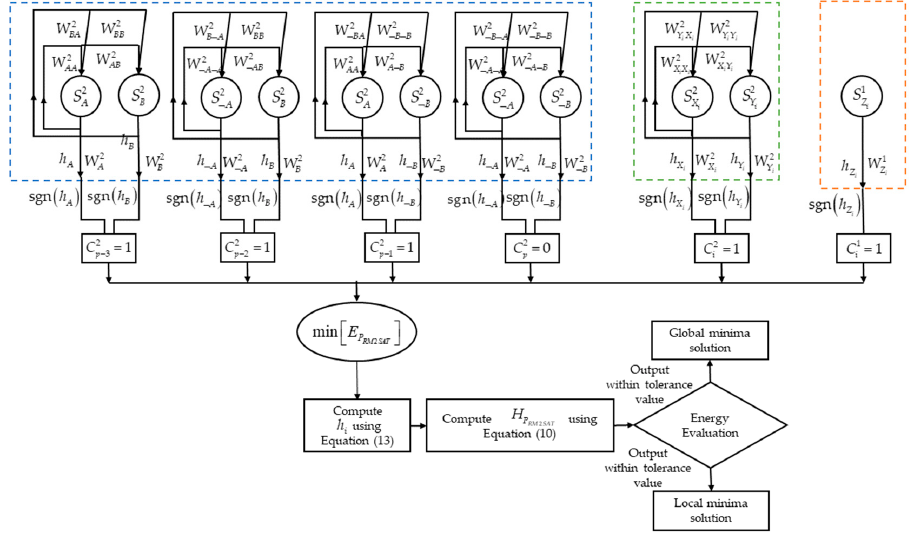
Figure 1. Schematic diagram for DHNN-RANMAX2SAT. Algorithm 1. The pseudocode of DHNN-RANMAX2SAT